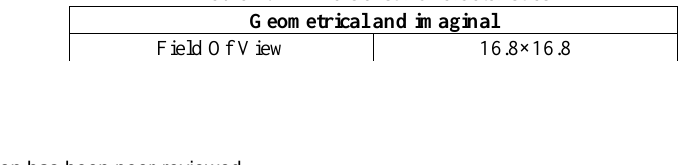
Table 2: FLIRi5 Sensor